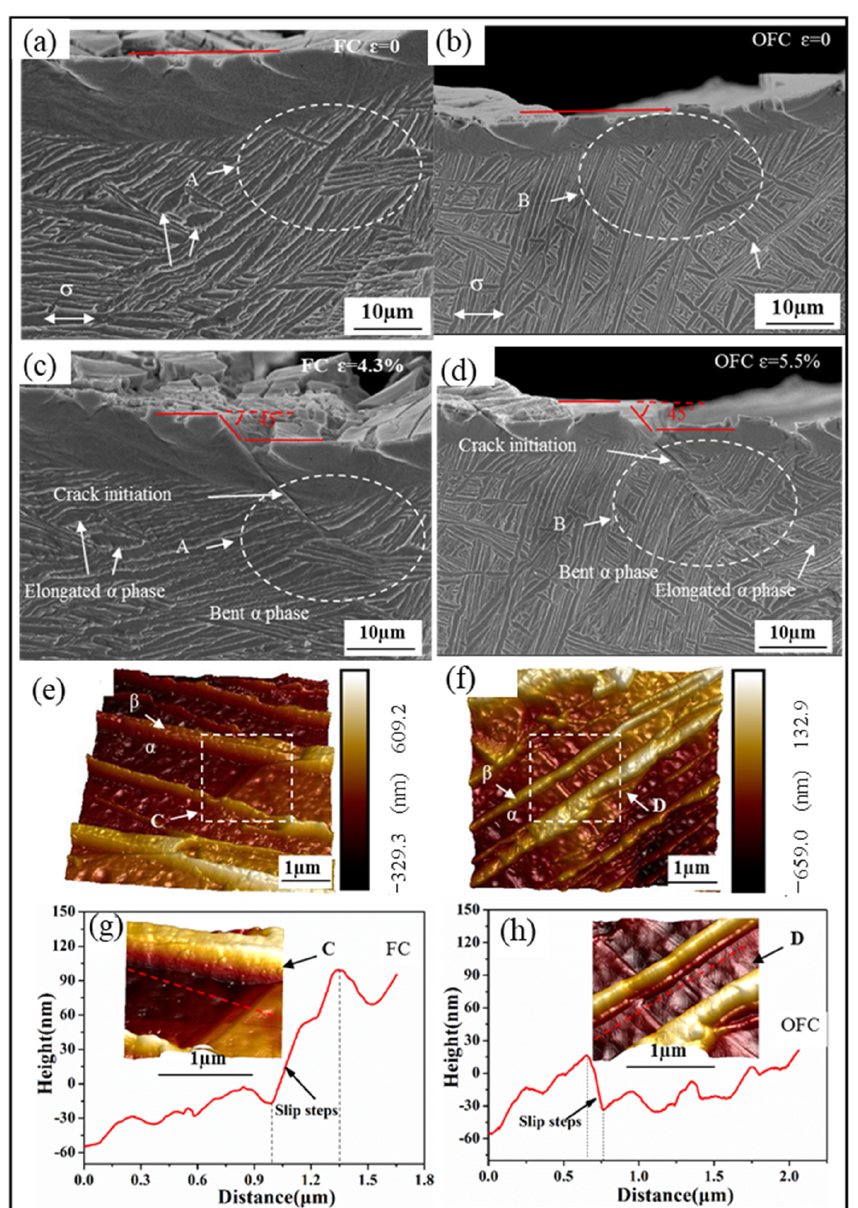
Figure 7. SEM images at different strain and AFM images of crack initiation of FC ( a , c , e,g ) and OFC ( b , d , f,h ).